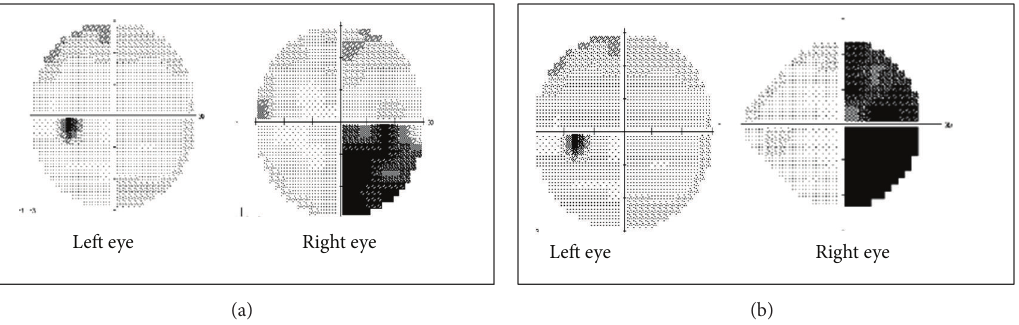
Figure 1: Comparison between initial visual field testing and 3-month follow-up visual field testing. ( a) Initial visual field test showing right eye inferotemporal visual field deficit. (b) Worsening of visual field deficit in right eye at 3-month follow-up visual field testing.